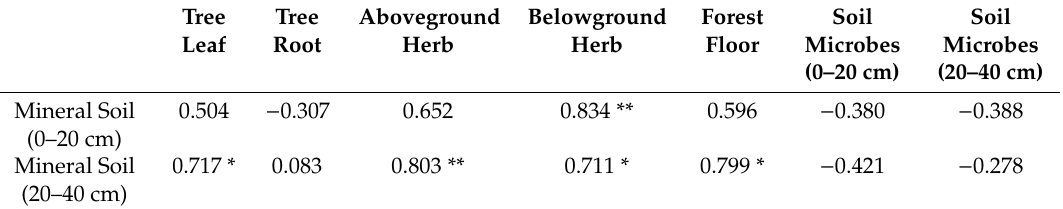
Table 4. The relationship among the di ff erent components N:P in P. asperata plantations. Tree Tree Aboveground Leaf Root